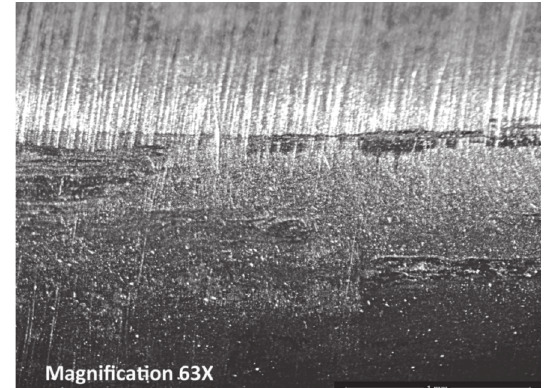
Light microscopy image from inferior ridge of the FNE Fig. 8: from Patient 2 with medial migration showing both transverse and longitudinal scratch marks.